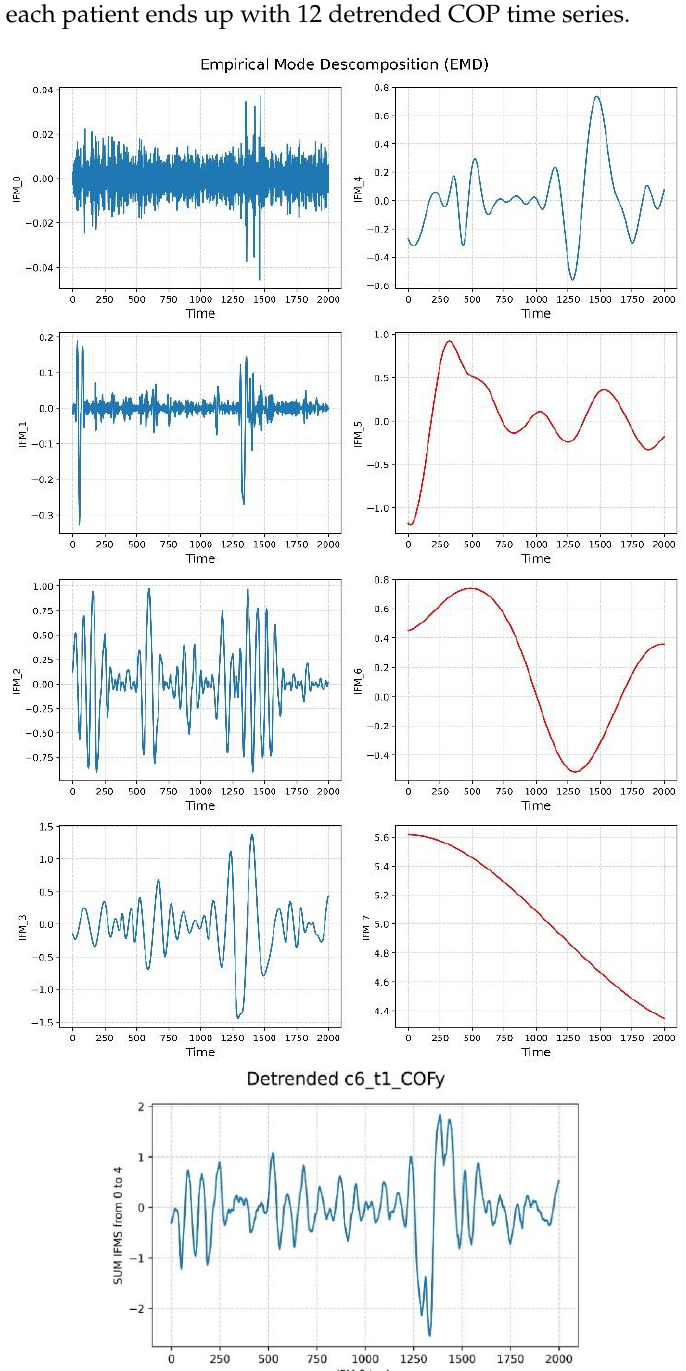
Figure 4. Empirical Model Decomposition to detrend COP.